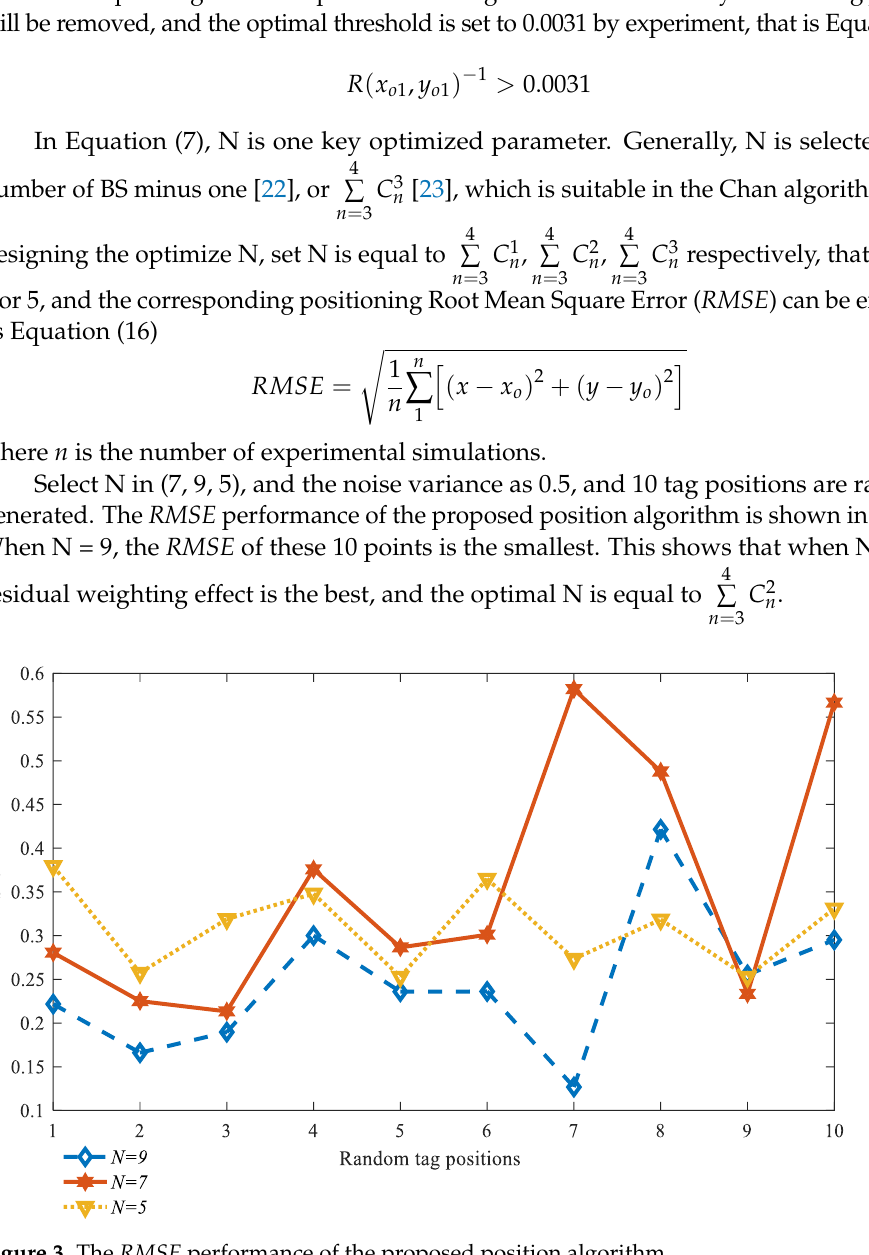
Figure 3. The RMSE performance of the proposed position algorithm .